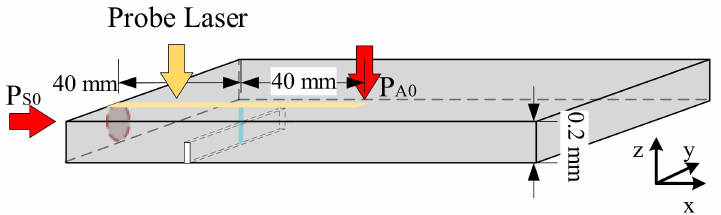
Figure 4. Aluminum plate sample with an artificial notch at the lower surface; the blue stripe indicates the position of probe laser on the y